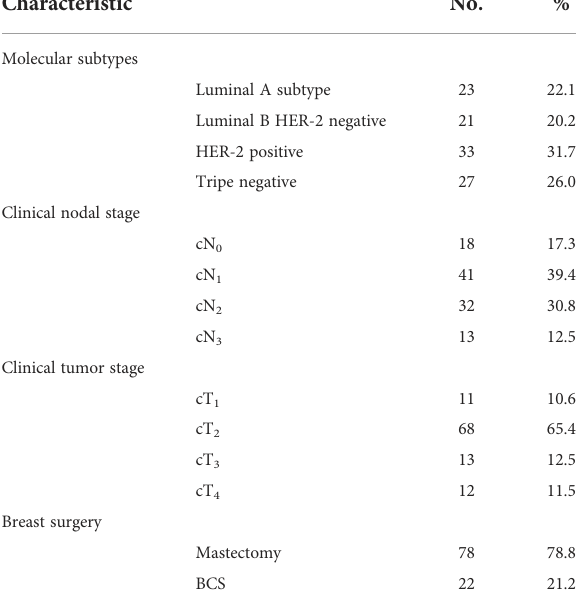
TABLE 2 Patients according to the different shrinkage classi fi cation modes.